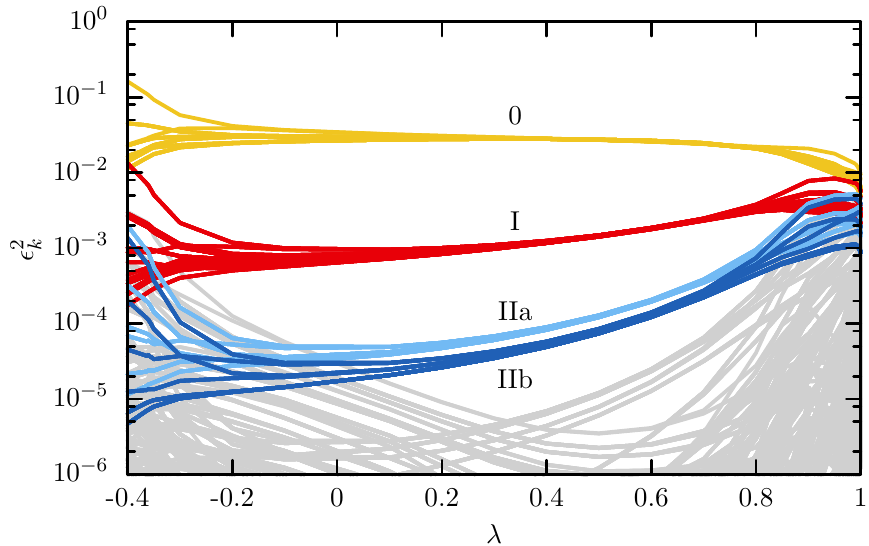
Figure 9: Entanglement spectrum of the RVBS: Reduced density matrix eigenvalues from a vertical cut through a 30 × 10 cylinder between sites n = 10,11 are plotted over the coupling λ . In the bulk of the RVBS phase, degenerate levels 0, I, IIa and IIb (yellow, red, bright and dark blue) are highlighted.